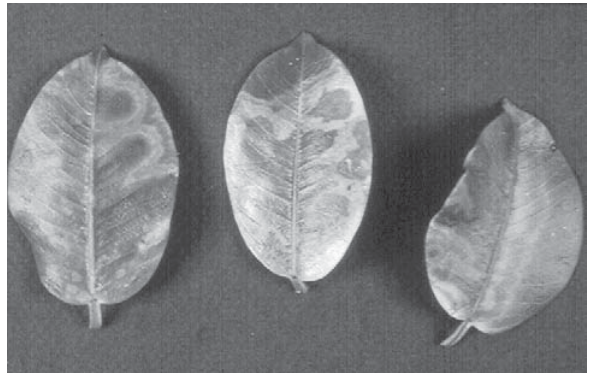
Fig. 1. Yellow rings on old leaves of M. sanderi natural- ly infected with